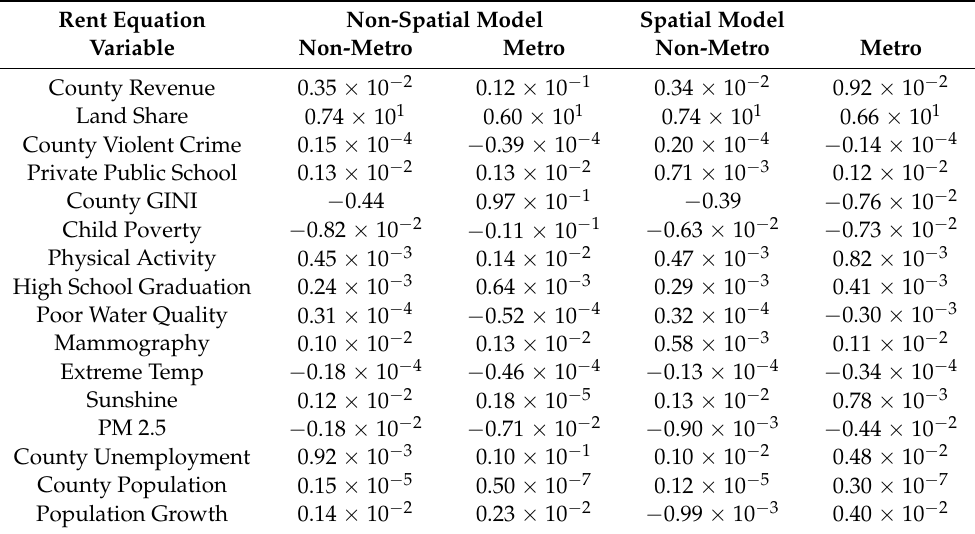
Table 2. Total marginal effects for rent equations in the continental United States: metro versus non-metro and non-spatial versus spatial